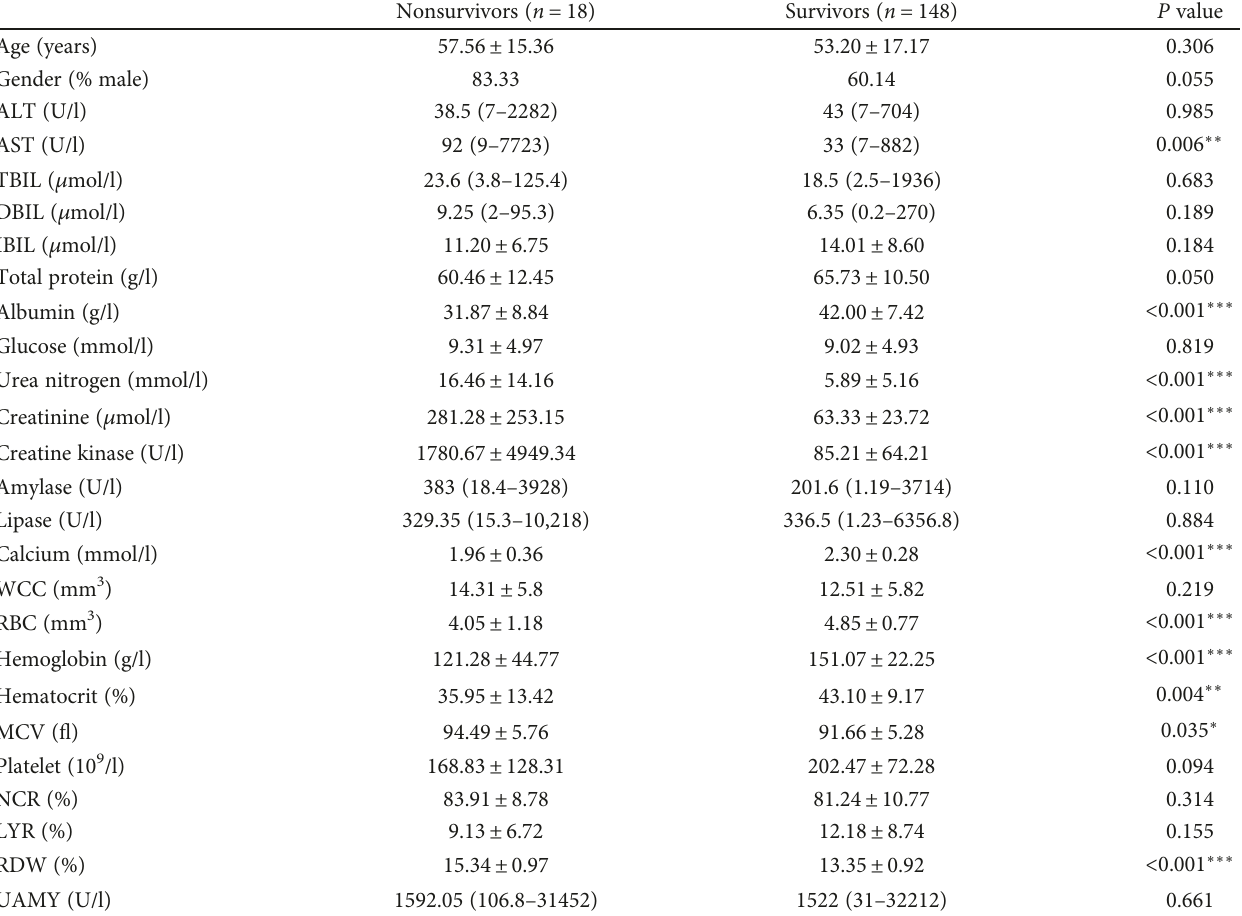
Table 1: Clinical characteristics and laboratory data of survivors and nonsurvivors of